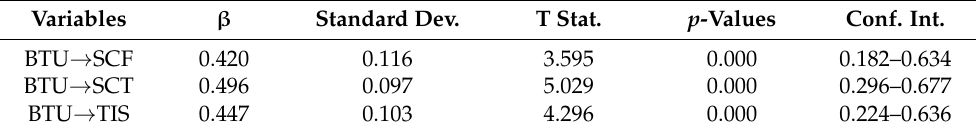
Table 7. Research model